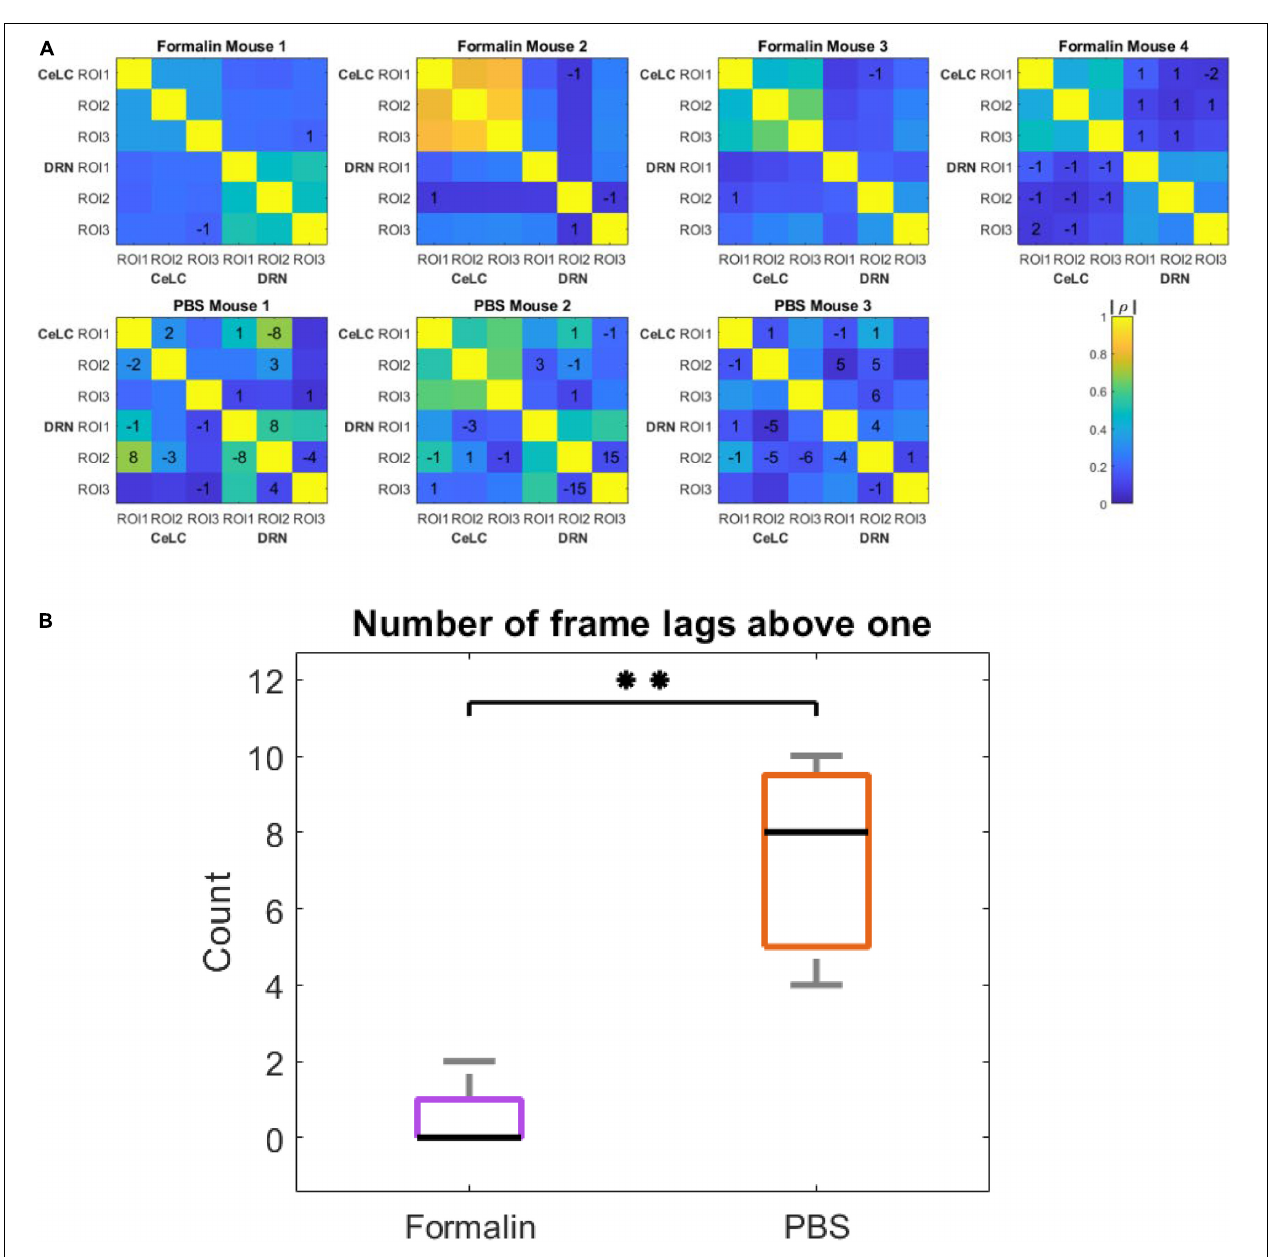
FIGURE 9 | Cross- and auto-correlation analysis in all mice. (A) Heatmap showing time lags with the highest cross-correlation coefficients. ROIs from CeLC and ROIs from DRN in each mouse were cross-correlated. The values written indicate the time lag of first-differenced DRN data in frame number that showed the highest cross-correlation with the original unshifted first-differenced CeLC data. No value means the best lag was at 0. The color indicates the cross-correlation coefficient ( ρ )from low (blue) to high (yellow) in absolute values. (B) Box plot of the number of frame lags that were above 1 in both treatment groups. Kruskal-Wallis test was performed and a significant difference was computed ( ∗∗ p = 0.00773, α = 0.05).